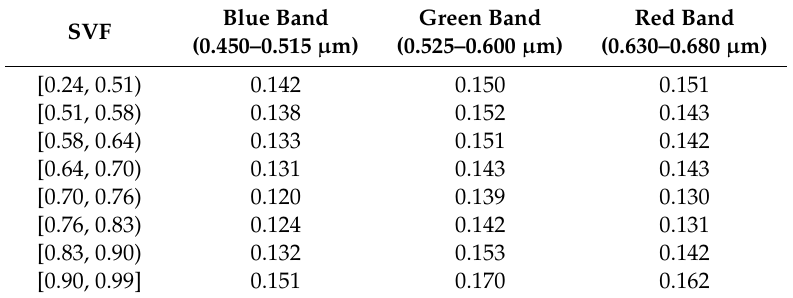
Figure 5. Urban 3D surface reflectance derived from the urban solar radiative transfer (USRT) model using Landsat 8 data within the study area. Table 2. Average reflectance in blue, green and red band under different SVFs within the study area.